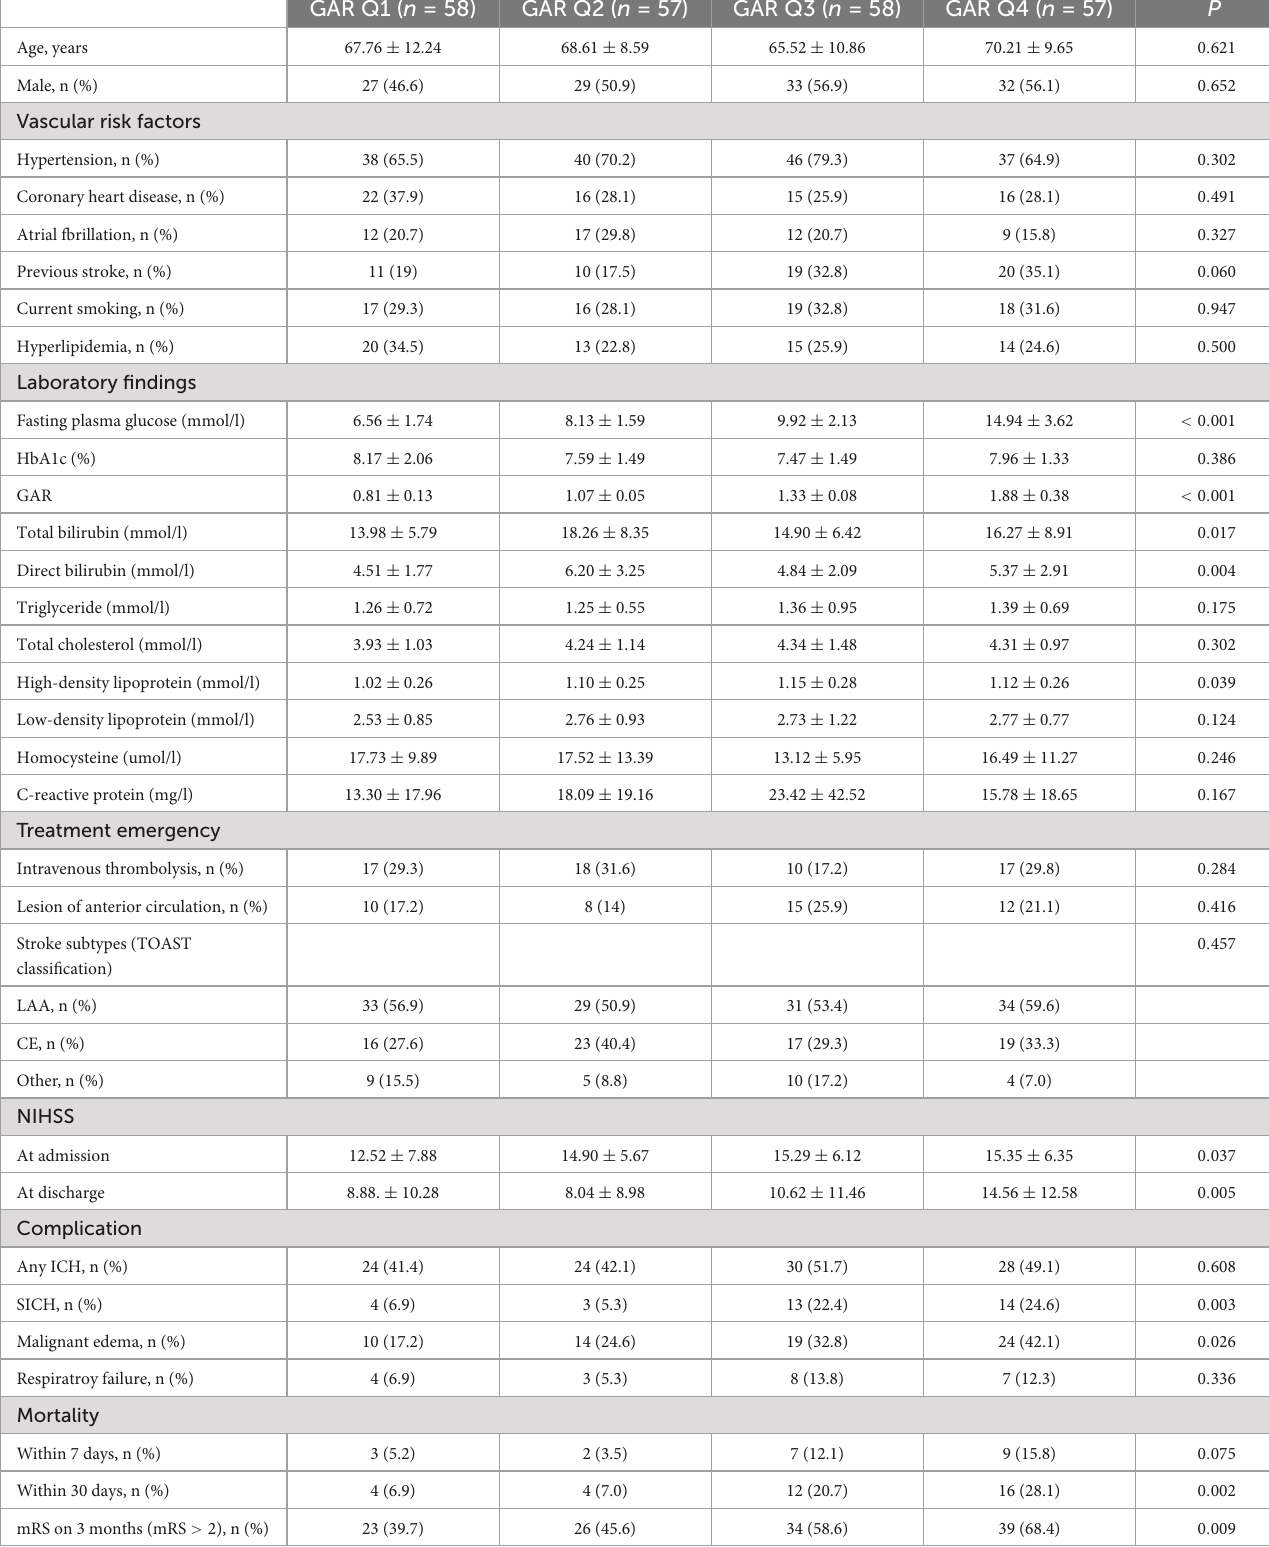
TABLE 3 Demographics, clinical data, complications and functional outcomes of diabetic